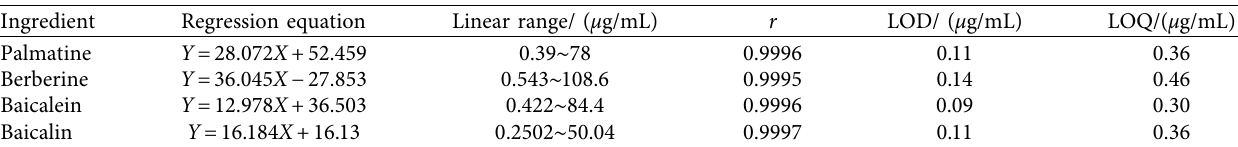
Table 3: Linear relationships of various